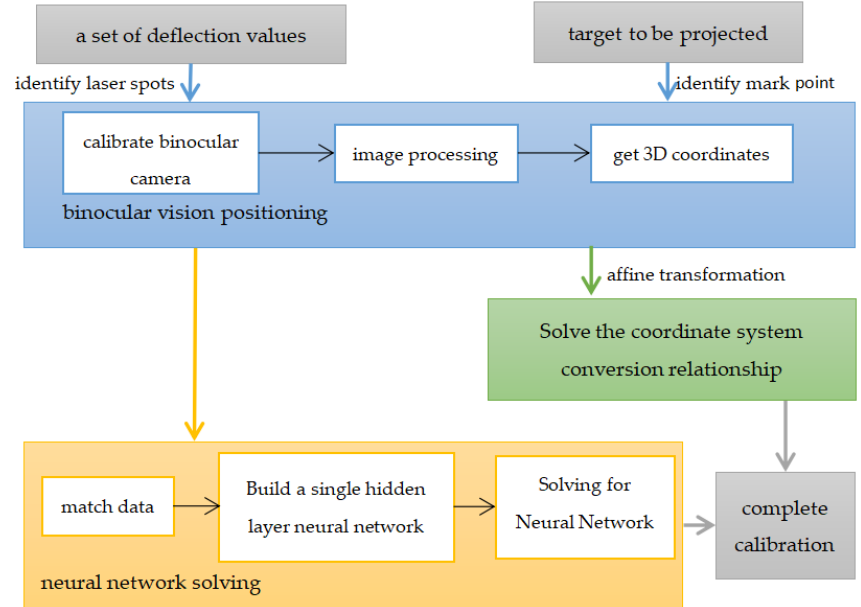
Figure 7. The block-level diagram of the calibration.